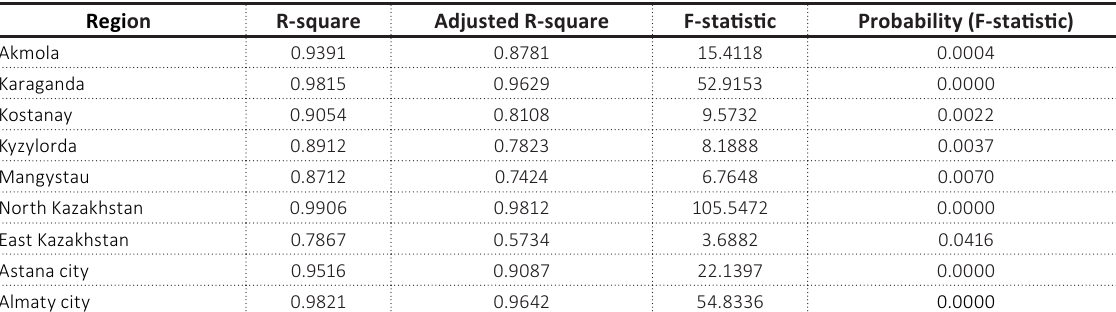
Table 4. Estimated indicators of multifactor models by regions of Kazakhstan for 2002–2021 F-statistic Probability